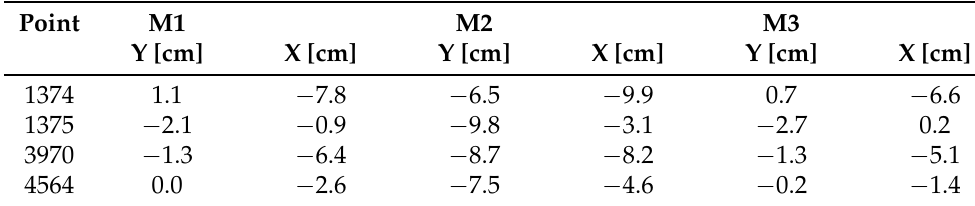
Table 7. Results of the different methods using all control points within 500 m around parcel 467/1: M1 (local transformation by 2D Helmert transformation), M2 (IDW based on residuals), and M3 (IDW based on homogeneous